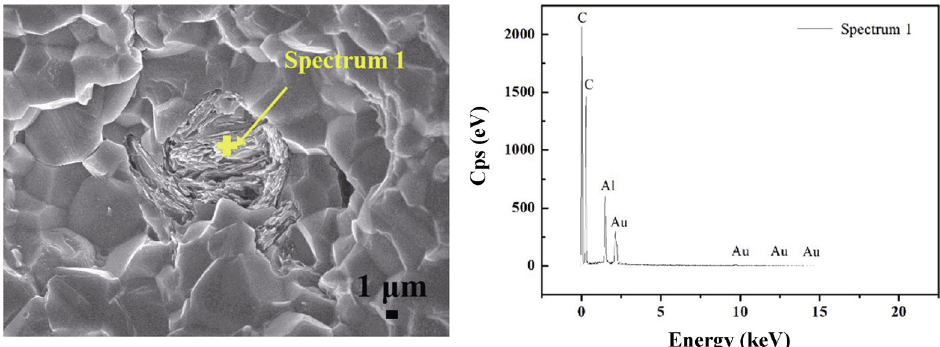
Fig. 7 Microstructure (ultrasonic cleaning) and EDS diagrams of 4 wt% SG/AlN